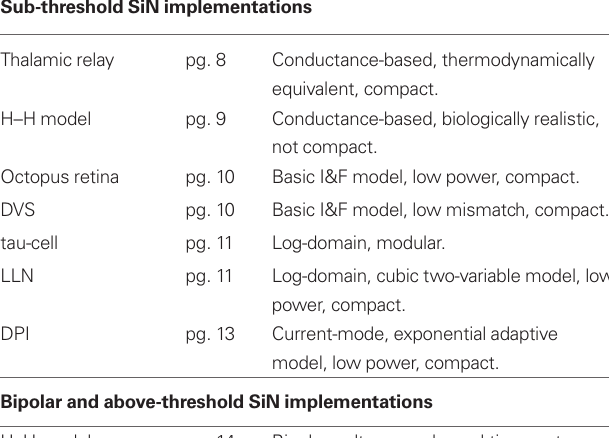
Table 2 | Summary of SiN implementations described in this paper and main